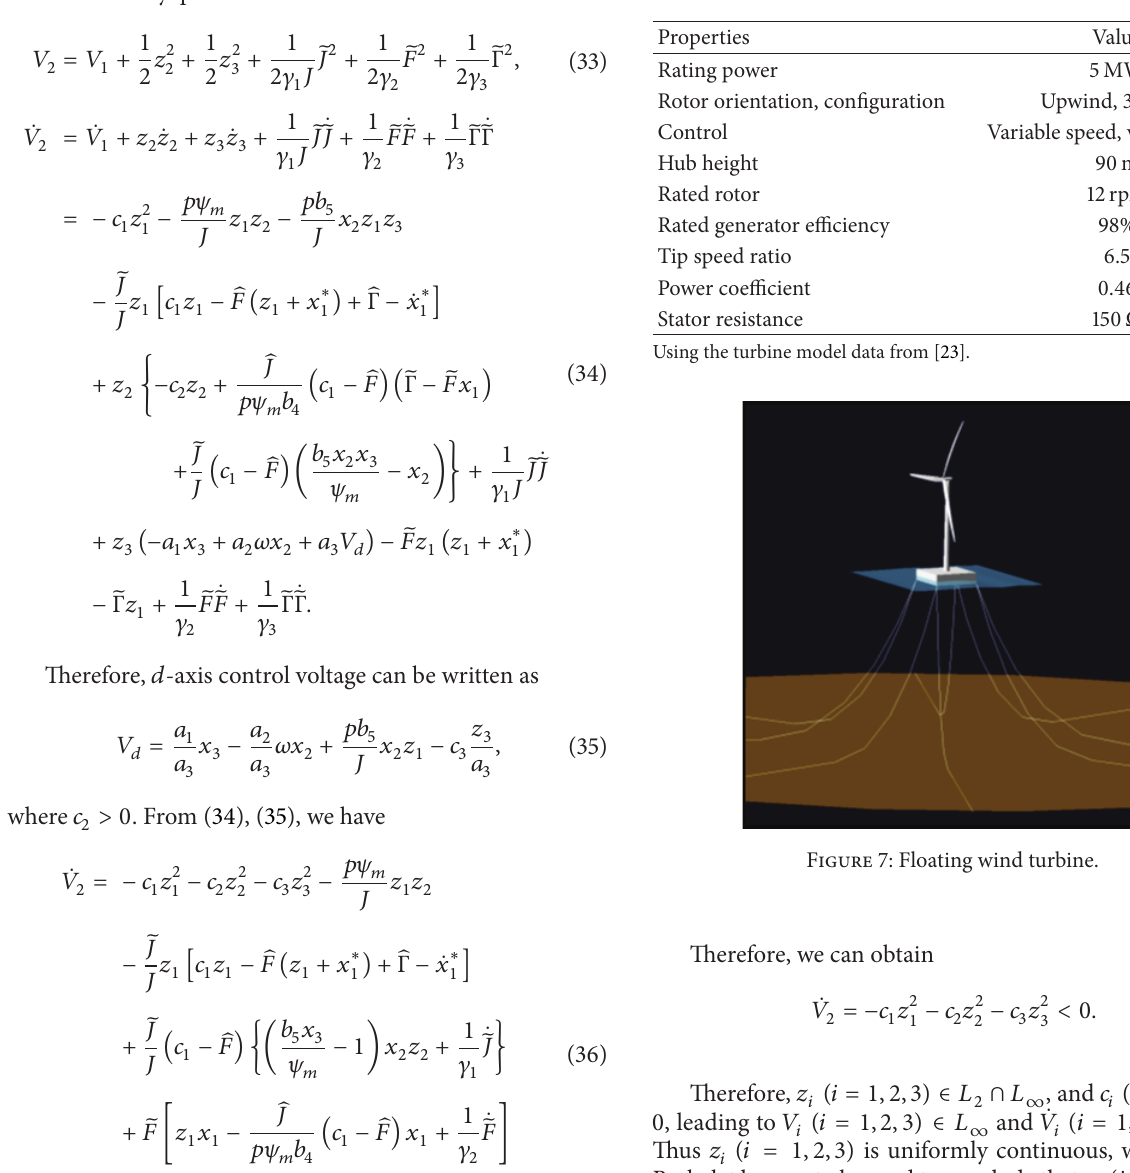
Table 1: NREL 5 MW baseline wind turbine model properties.